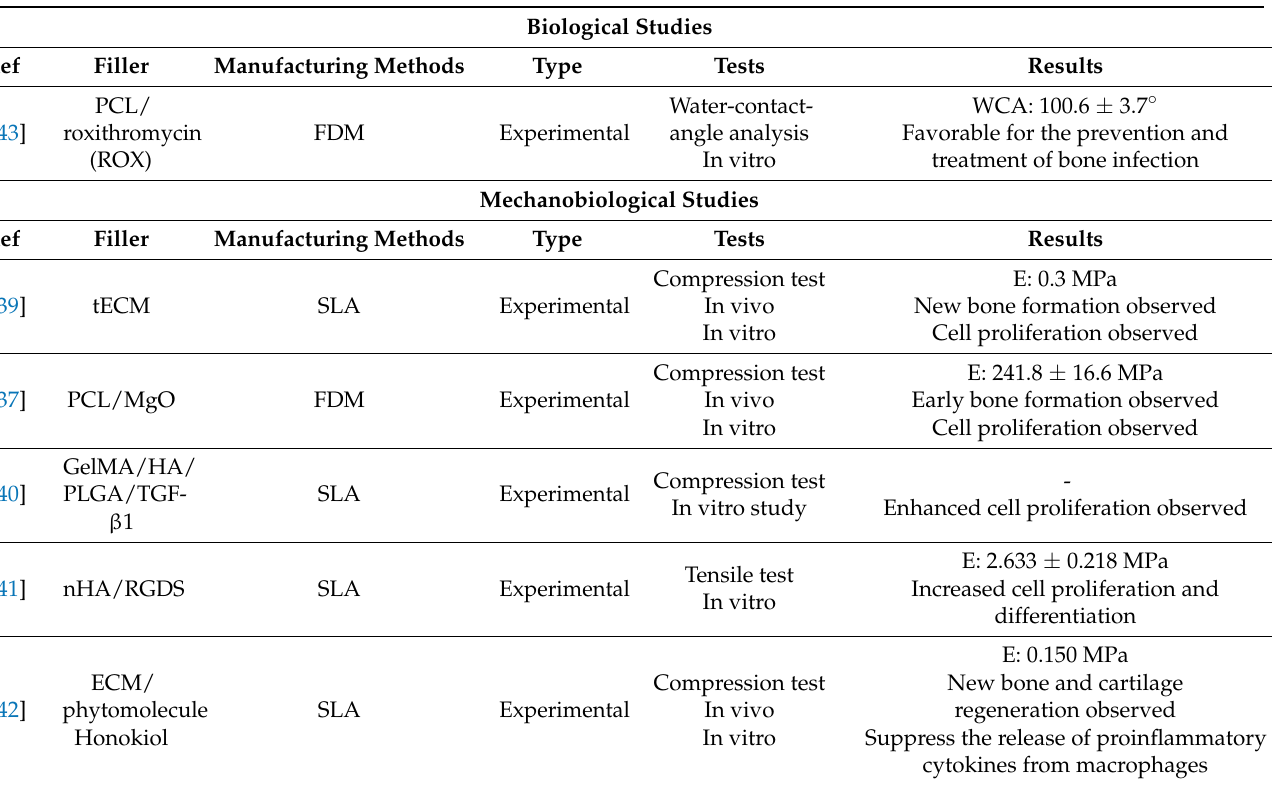
Table 5. Mechanobiological literature of PEG and its composite material; C: compressive strength, T: tensile strength, D: displacement, Y: yield strength, E: modulus of elasticity, WCA: water contact angle, B: bending strength, R: